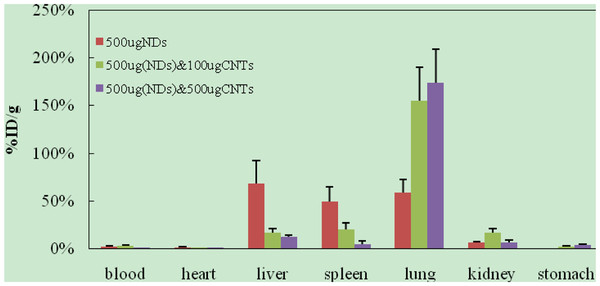
Effect of oMWCNTs doses on biodistribution of 500 μg 99mTc-NDs in mice 2 h after co-injection.